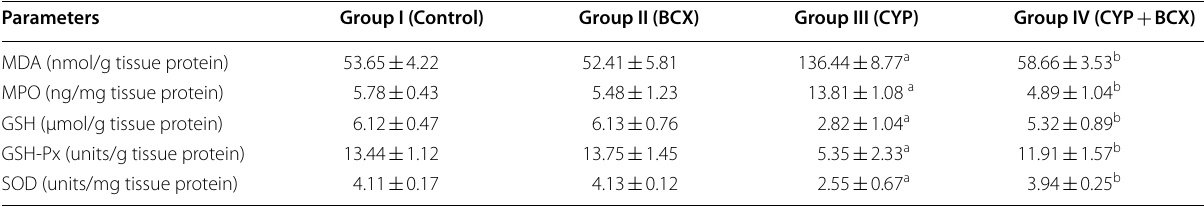
Data are expressed as mean standard deviation. Results were statistically analyzed by using Student’s t test at P < 0.05 ± a P < 0.0001 compared with the control group (group I) b P < 0.001 compared with the CYP group (group III) Table 3 Levels of malondialdehyde (MDA), myeloperoxidase (MPO), reduced glutathione (GSH), glutathione peroxidase (GSH-Px), and superoxide dismutase (SOD) in the different studied groups